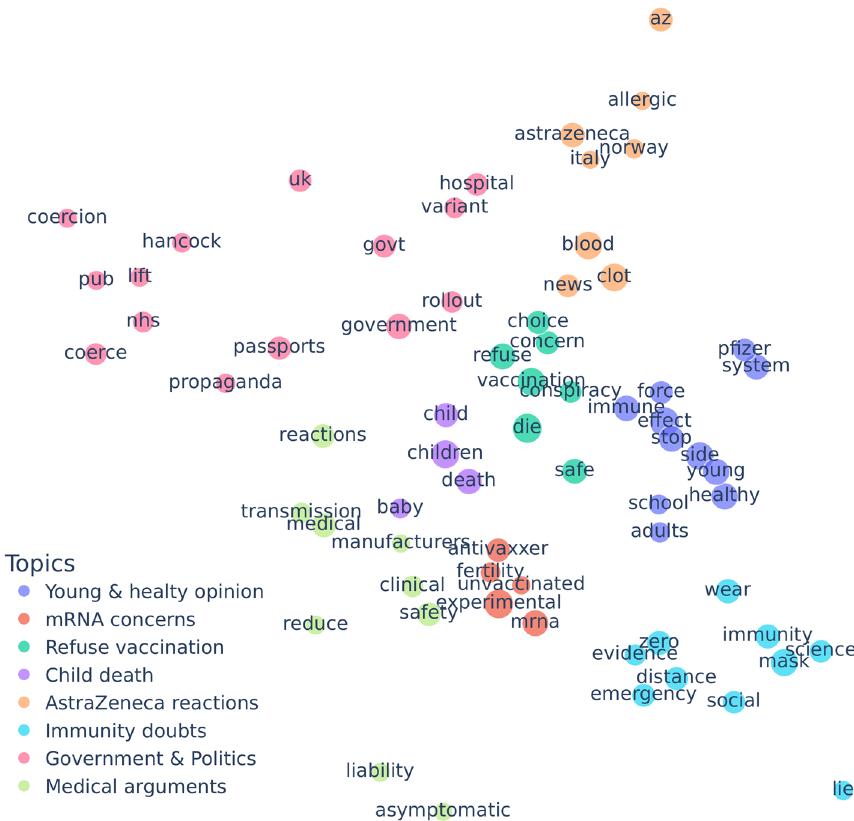
Fig. 15 Vax-skeptic topic space uncovered by Walklets